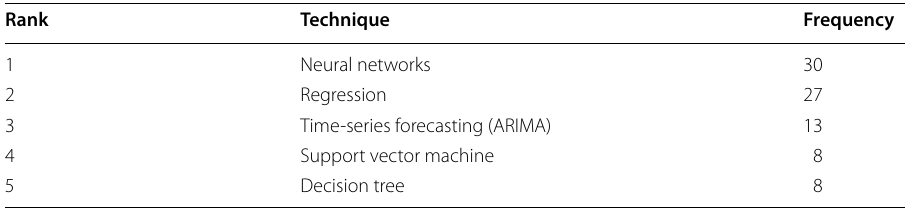
Table 2 Literature on BDA/machine learning techniques for supply chain demand forecasting